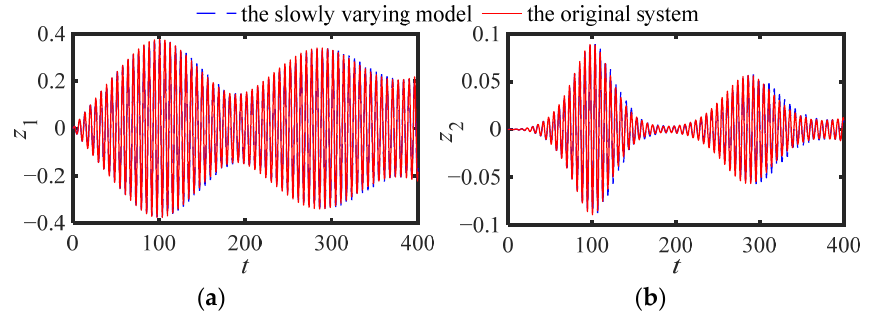
Figure 2. Displacement responses: ( a ) main structure, ( b ) NES ( ε 1 = 0).